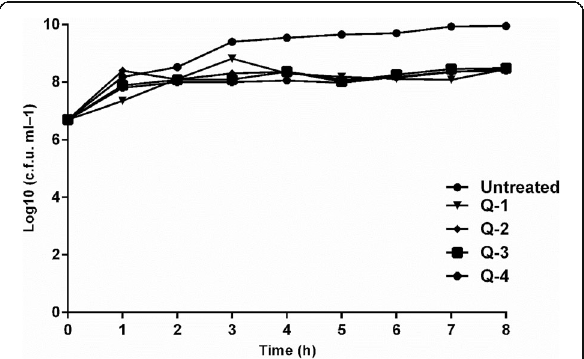
Fig. 2 TVCs of P. aeruginosa isolates grown in the presence of Q. infectoria gall extracts over 8 h; points denote the mean from three biological replicas. Q-1: ethyl acetate, Q-2: n-butanol, Q-3: ethanol, Q- 4: aqueous extract. Q-1: ethyl acetate, Q-2: n-butanol, Q-3: ethanol, Q-4: aqueous